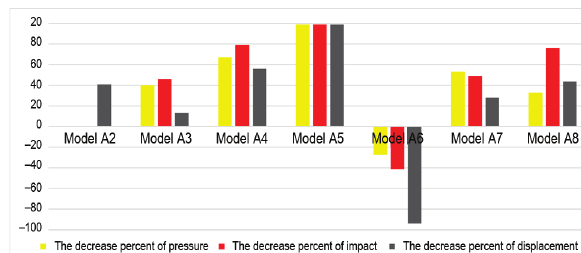
Fig. 11. Comparison chart of reduction percentage of maximum pressure, impact and displacement for laminated glass models as opposed to one-layer laminated glass model